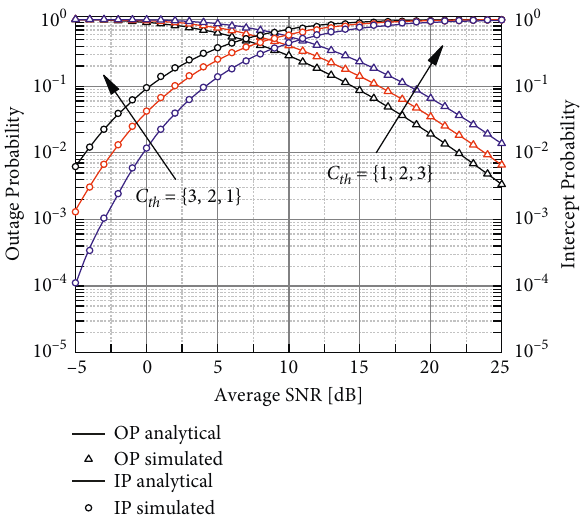
Figure 4: OP and IP versus average SNR for various values of C